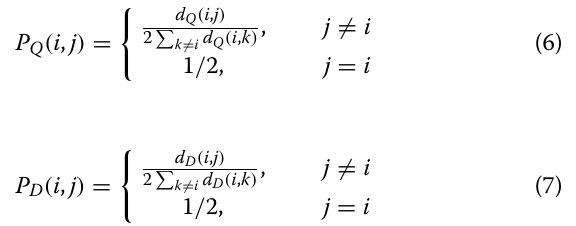
P Q and P D ) and the sparse kernels (denoted as Q Q D ) are defined on the vertex set V (see Eqs. (6)–(9)),